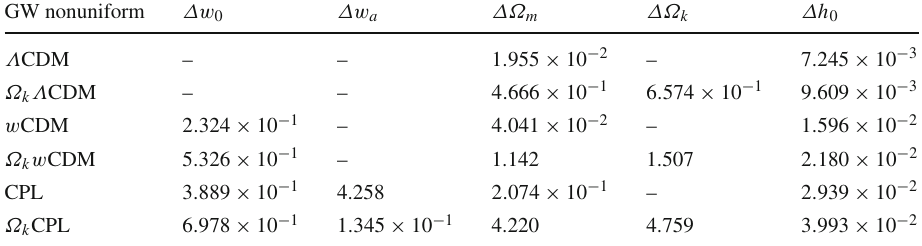
GW nonuniform Δw